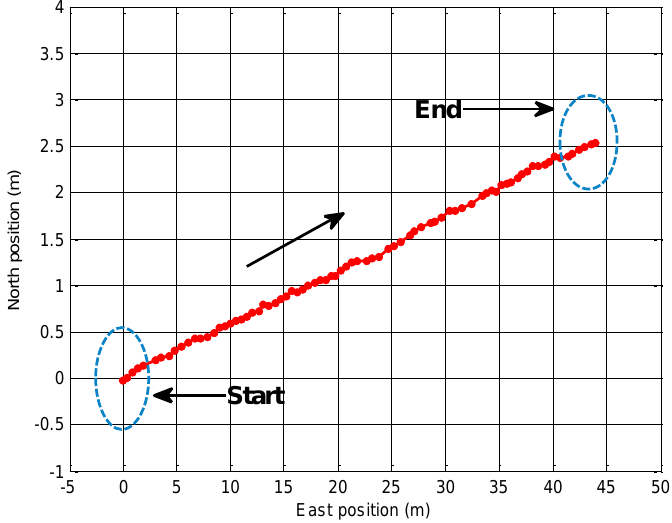
Figure 5. The trajectory of the real experiment